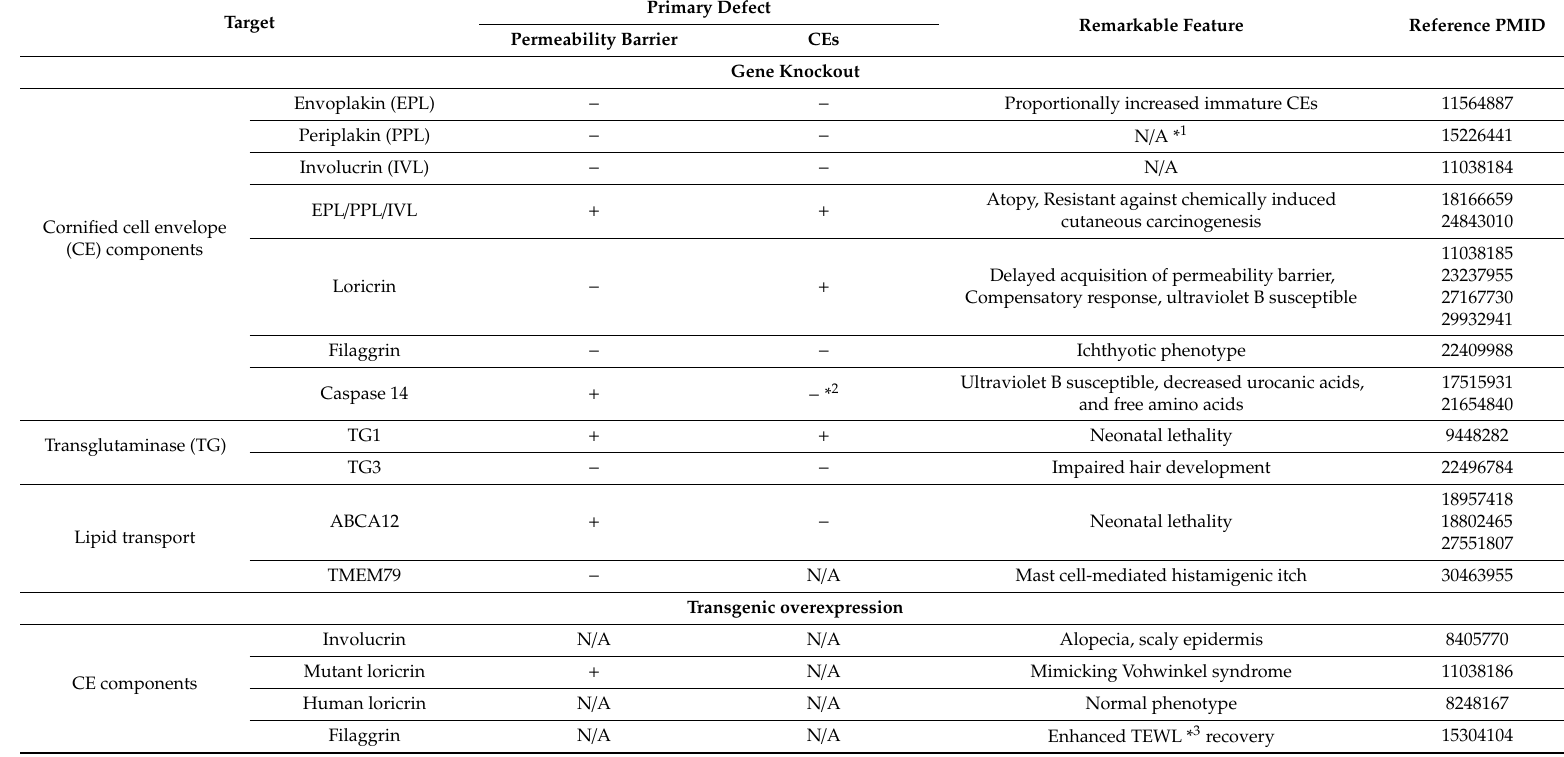
Table 2. Epidermal di ff erentiation and mouse